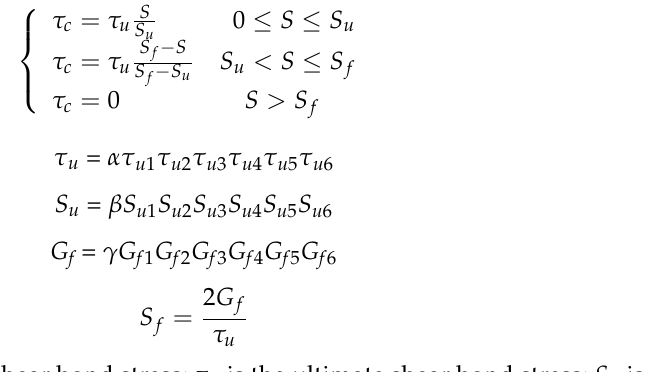
Figure 11. ( a ) Single shear bond strength and ( b ) double shear bond strength of specimens with varying age.